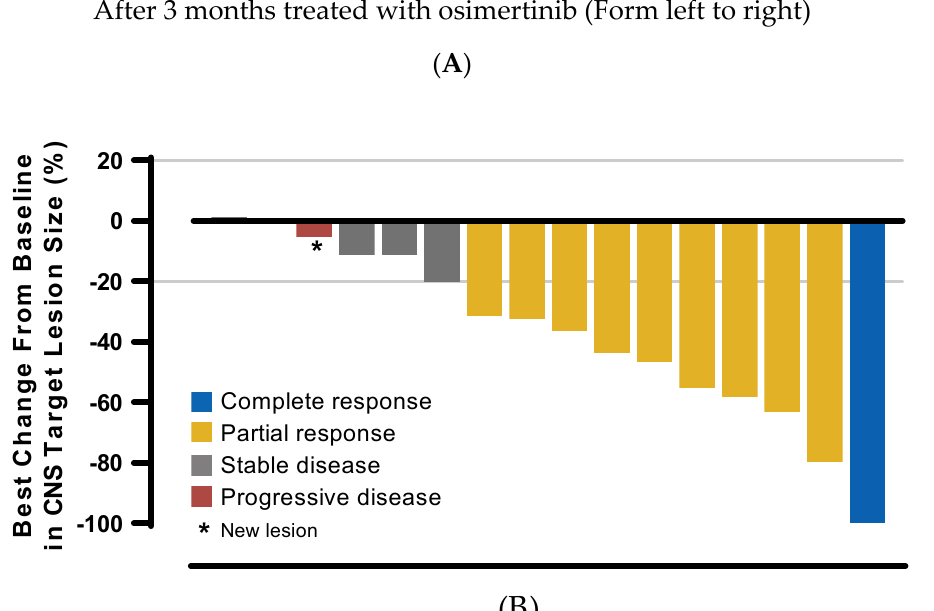
Figure 3. ( A ) Patient with LM disease who showed CR. ( B ) Best percentage change from baseline in target lesion size (CNS evaluable for response set). Best percentage change in target lesion size is the maximum reduction from baseline or the minimum increase from baseline in the absence of a reduction.